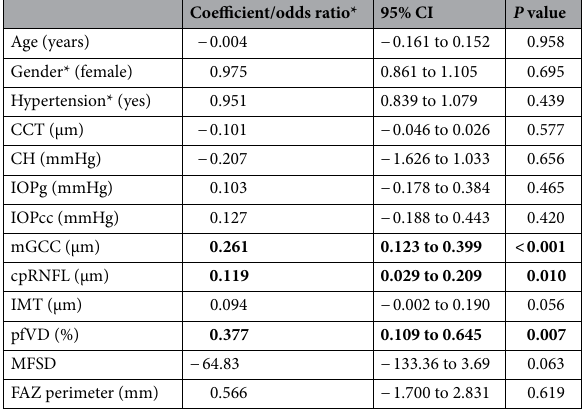
Coefficient/odds ratio* 95% CI P